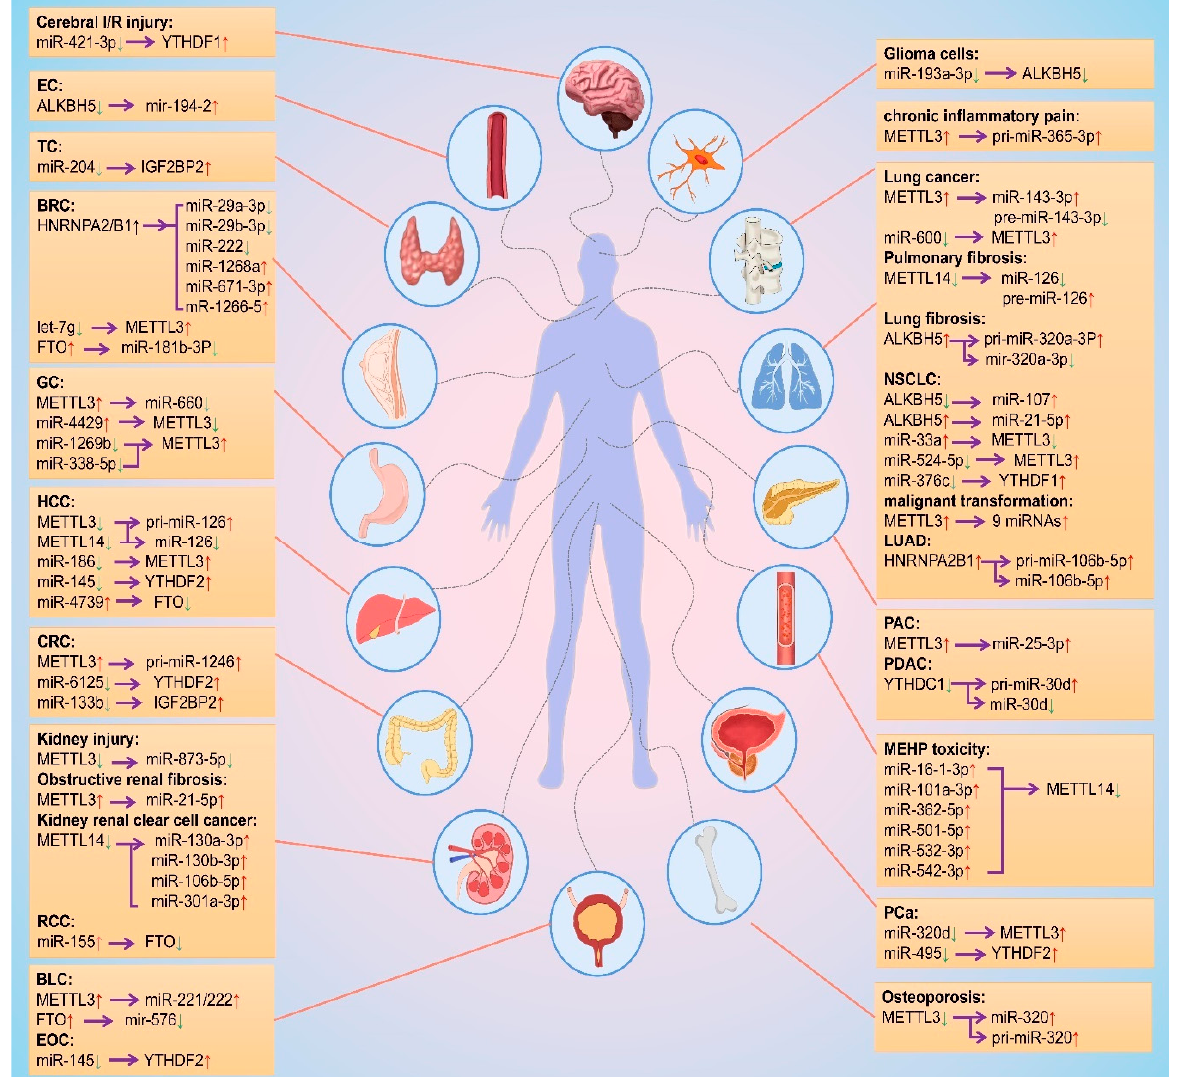
Figure 4. Mutual regulation between m 6 A modifications and miRNAs. The red and green arrows represent the level rise and fall, respectively. The purple arrows point to the regulated object. EC: esophageal cancer; TC: thyroid cancer; BRC: breast cancer; GC: gastric cancer; HCC: hepatocellular carcinoma; CRC: colorectal cancer; RCC: Renal cell carcinoma; BLC: bladder cancer; EOC: epithelial ovarian cancer; NSCLC: non-small cell lung cancer; LUAD: lung adenocarcinoma; PAC: pancreatic cancer; PDAC: Pancreatic ductal adenocarcinoma; PCa: prostate cancer.